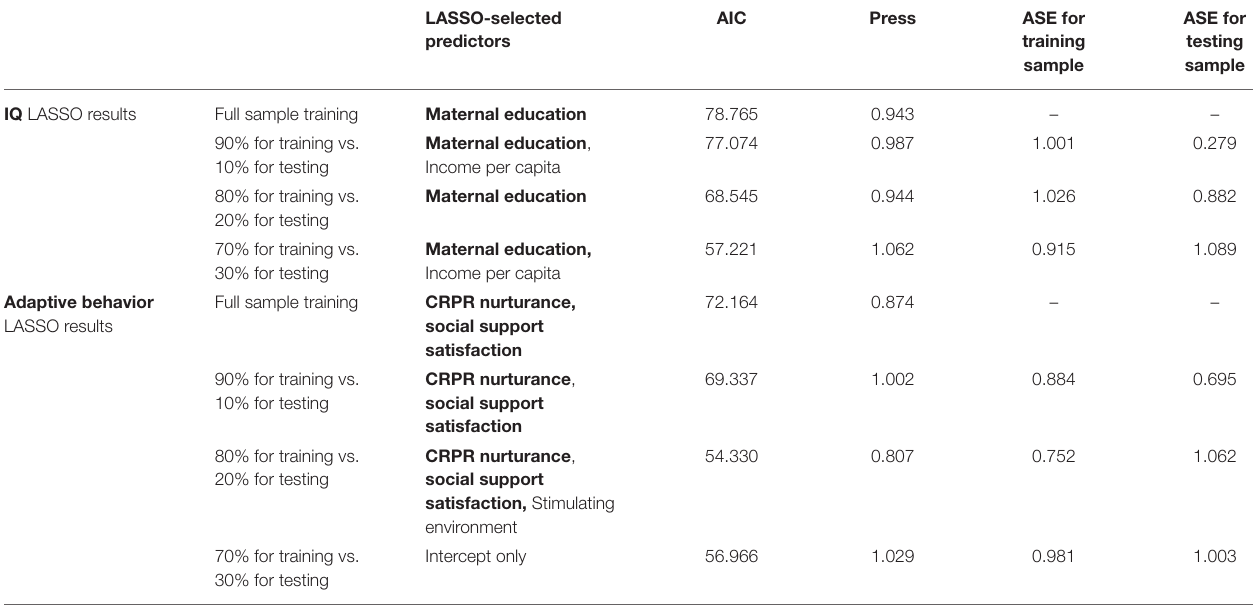
TABLE 3 | Results from LASSO models with adaptive behavior and IQ as outcomes with different sample partitioning.